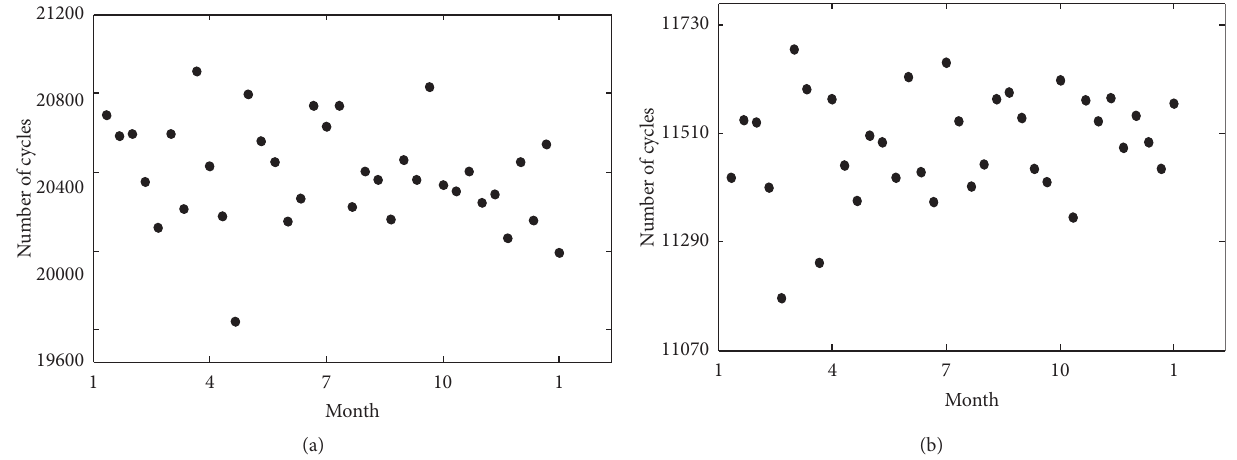
Figure 12: The scattered diagrams of N d : (a) the rib-to-deck joint and (b) the rib-to-rib joint.